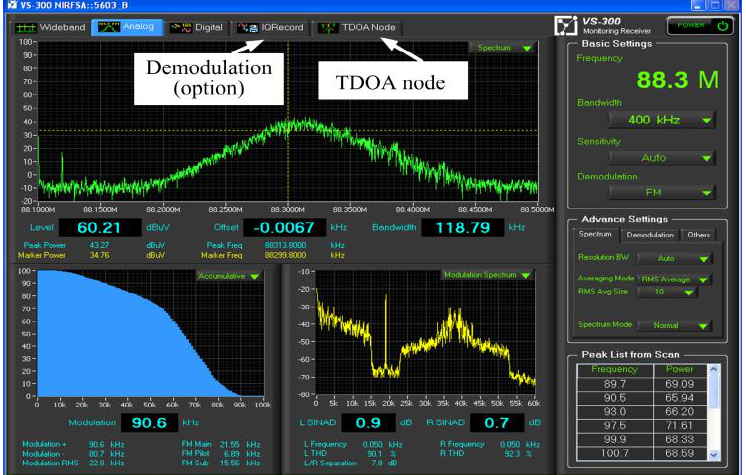
selecting the sampling time, filter, bandwidth, etc .